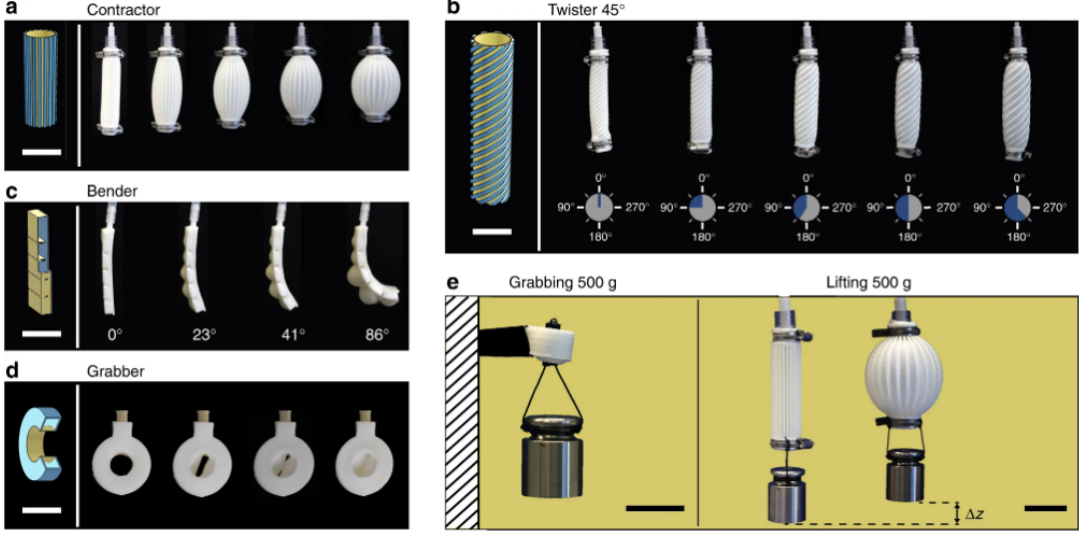
Figure 9. Soft robotic constructed by 3D printing [111] (Open Access).